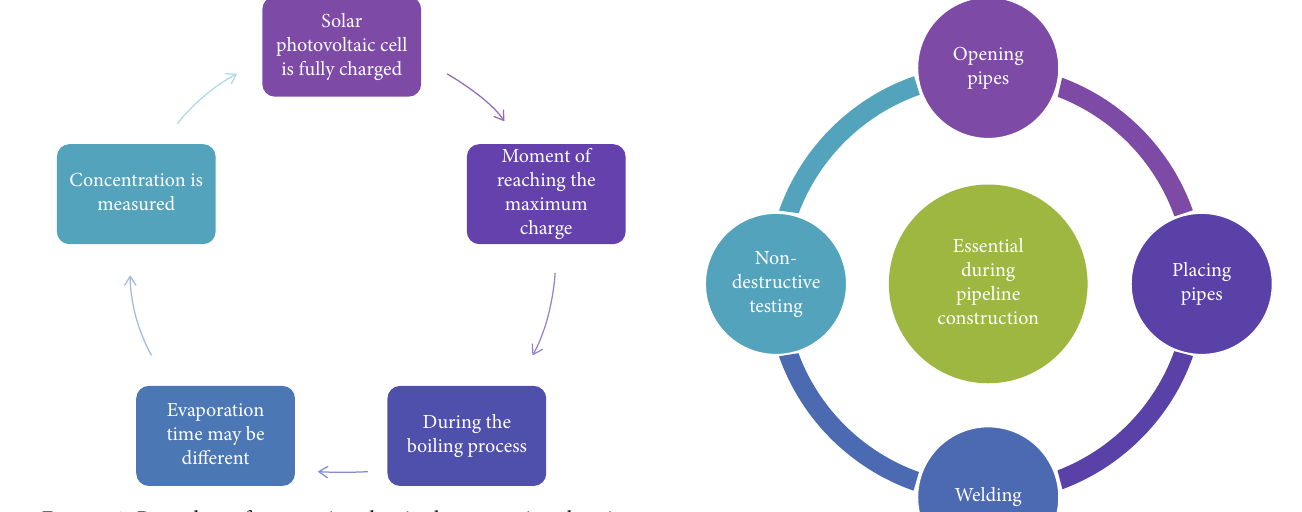
Figure 1: Procedures for restoring density by corrective charging.